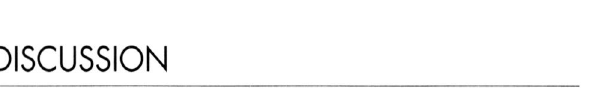
depths, to 13° C in 30 centimeters, and 11°C in 50 cen timeters and 100 centimeters on the 91 st